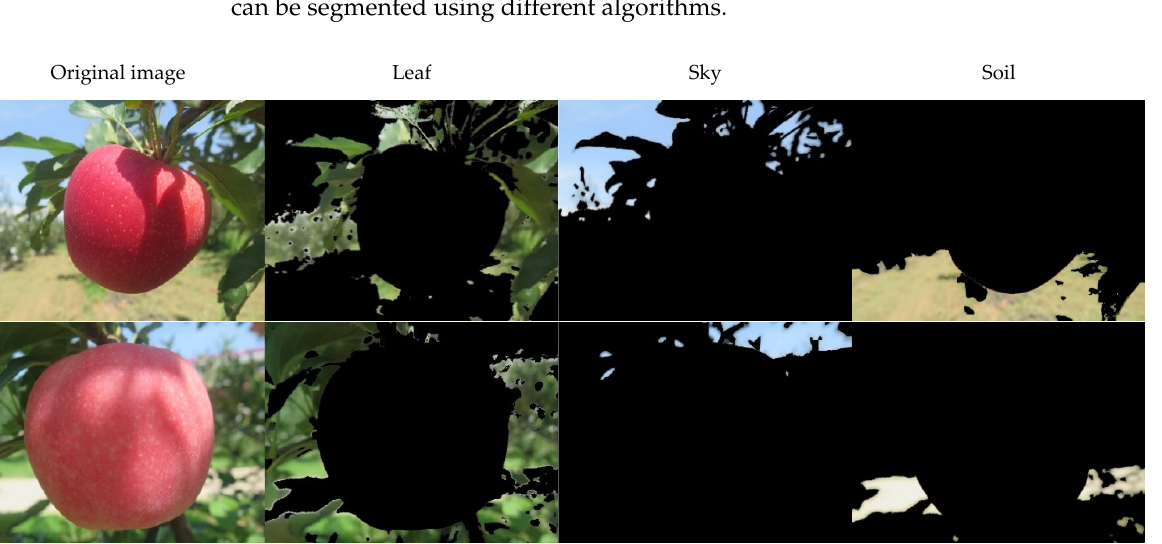
can be segmented using different algorithms.